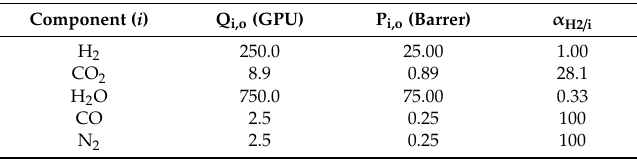
Table 1. Component permeance (Q i,o ) and permeability (P i,o ) values used reported in gas permeation units (GPU) and barrer, respectively, as well as the ideal selectivities ( α H2 / i ) of hydrogen relative to other components in the